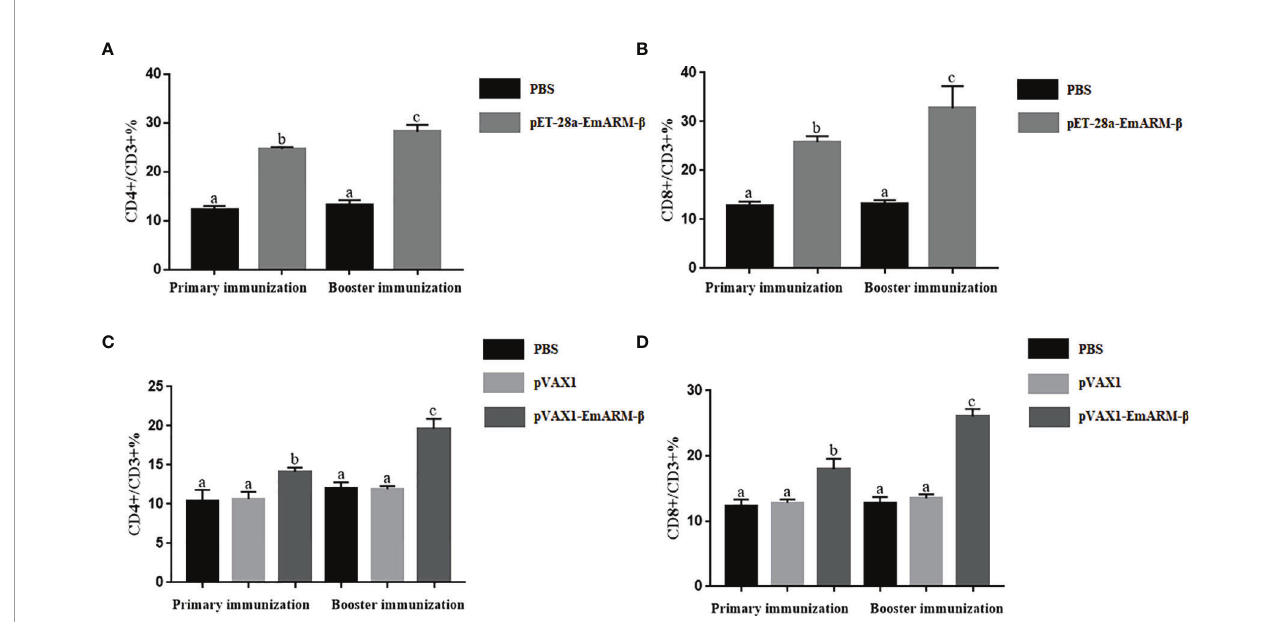
FIGURE 8 | The ratio of T lymphocyte subset in EmARM- b immunized chicken spleens. (A) The ratio of CD4 + /CD3 + T lymphocyte subset in spleens from chickens immunized with recombinant protein pET-28a-EmARM- b . (B) The ratio of CD8 + /CD3 + T lymphocyte subset in spleens from chickens immunized with recombinant protein pET-28a-EmARM- b . (C) The ratio of CD4 + /CD3 + T lymphocyte subset in spleens from chickens immunized with recombinant plasmid pVAX1-EmARM- b . (D) The ratio of CD8 + /CD3 + T lymphocyte subset in spleens from chickens immunized with recombinant plasmid pVAX1-EmARM- b . The small letters (a-c) indicate difference between groups in the same panel. The same letter indicates no signi fi cant difference between different groups (p > 0.05). The different letter indicates signi fi cant difference between different groups (p < 0.05).